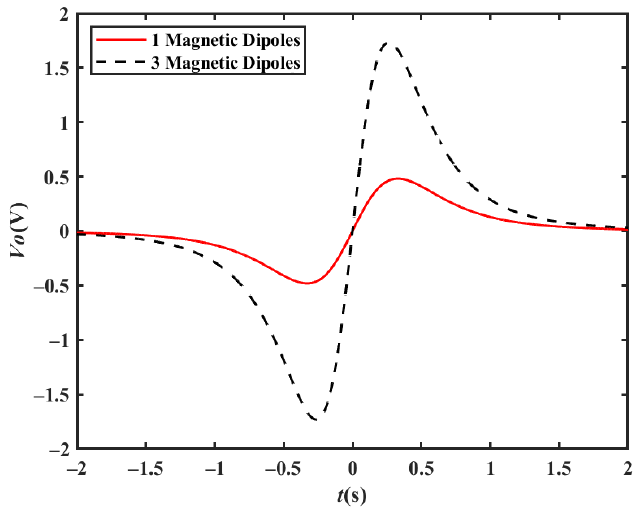
Figure 6. Simulation output waveforms of multi-magnetic dipole model( v = 40 km/h).